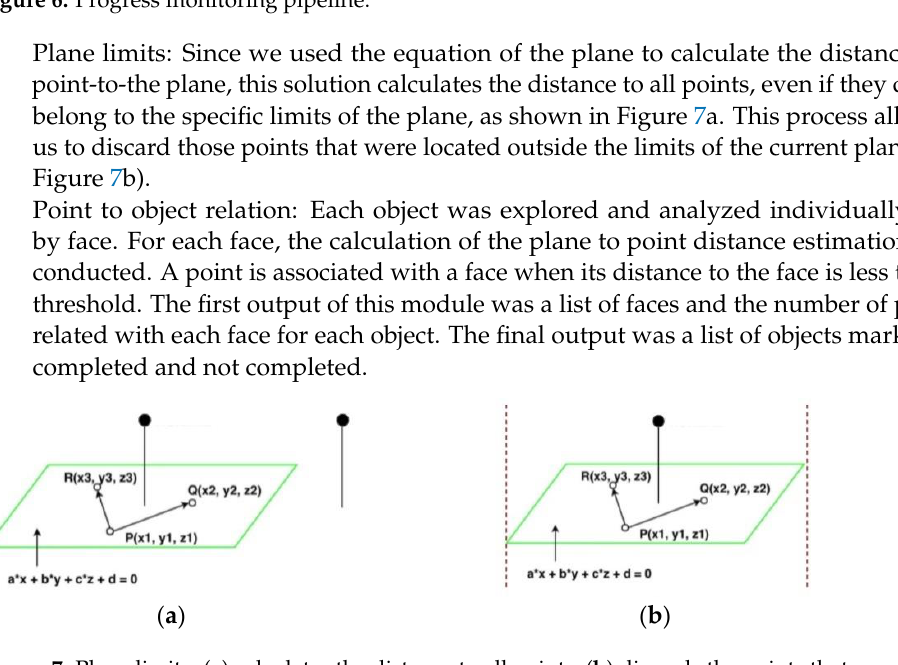
( b ) Figure 7. Plane limits: ( a ) calculates the distance to all points, ( b ) discards the points that are out- side the limits of the current plane.